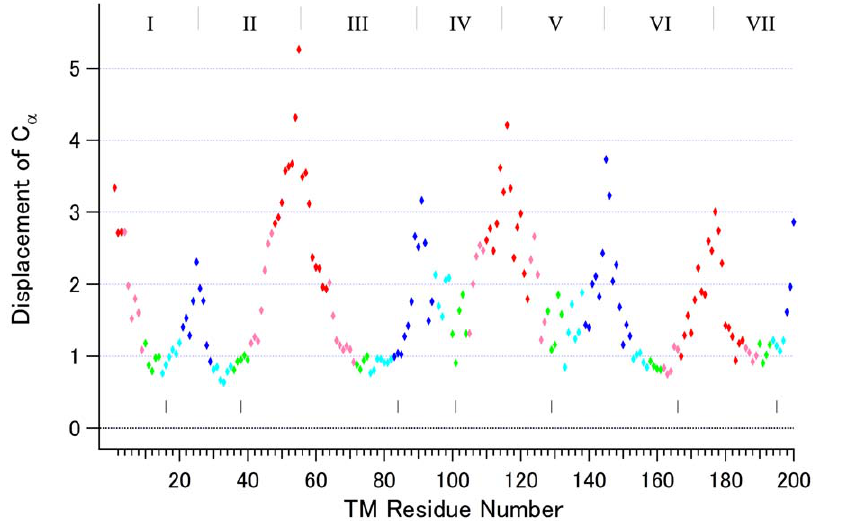
Figure 2. Averaged displacement (A˚) of C a atoms of 200 residues. Thirty-six pairwise deviations at each position were averaged and plotted against a serial number of residues in a 7TM bundle. The residues located in the same section (slab) are colored in red, section 1; pink, section 2; green, section 3; cyan, section 4; blue, section 5. The borders between the adjacent helices are shown with gray bars at the top of the panel, while the positions of seven *.50 residues are shown with short black bars near the zero line of the graph.